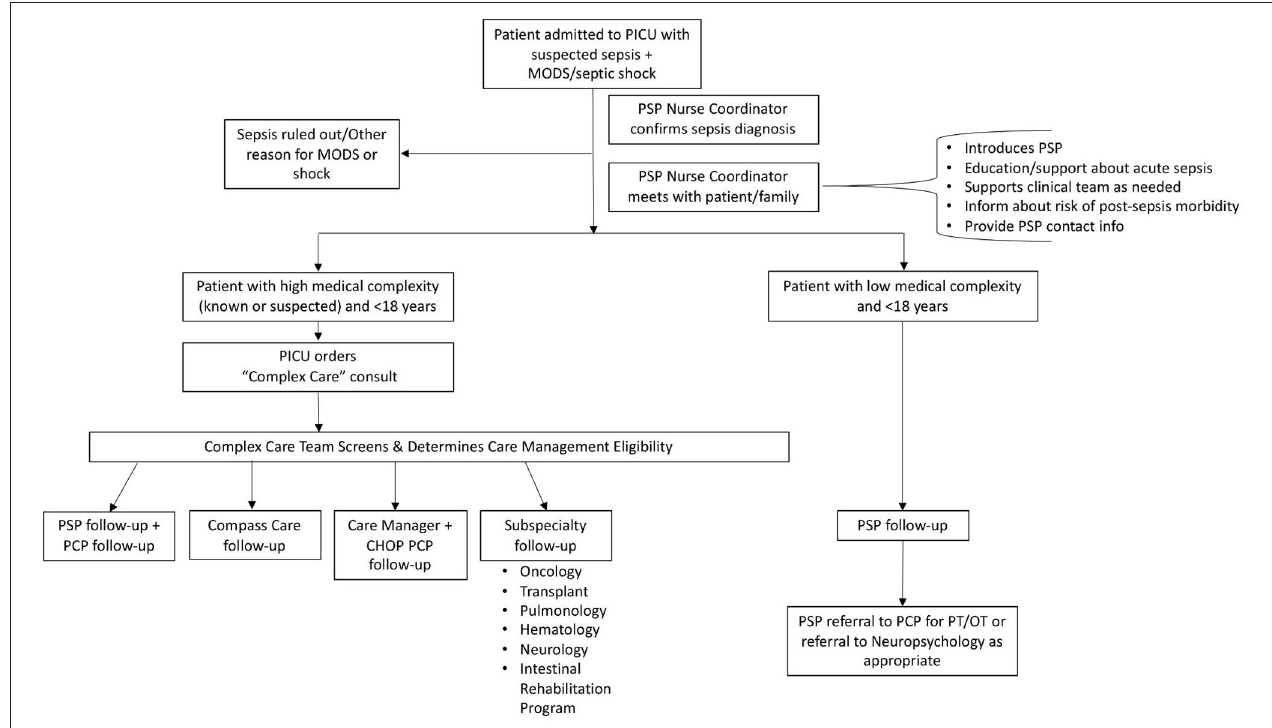
FIGURE 1 | Initial sepsis survivorship workflow. The planning phase resulted in the initial follow-up workflow for patients cared for in the PICU with sepsis. PICU, Pediatric Intensive Care Unit; MODS, multiple organ dysfunction syndrome; PSP, Pediatric Sepsis Program; PCP, primary care provider; CHOP, Children’s Hospital of Philadelphia; PT/OT, physical therapy/occupational